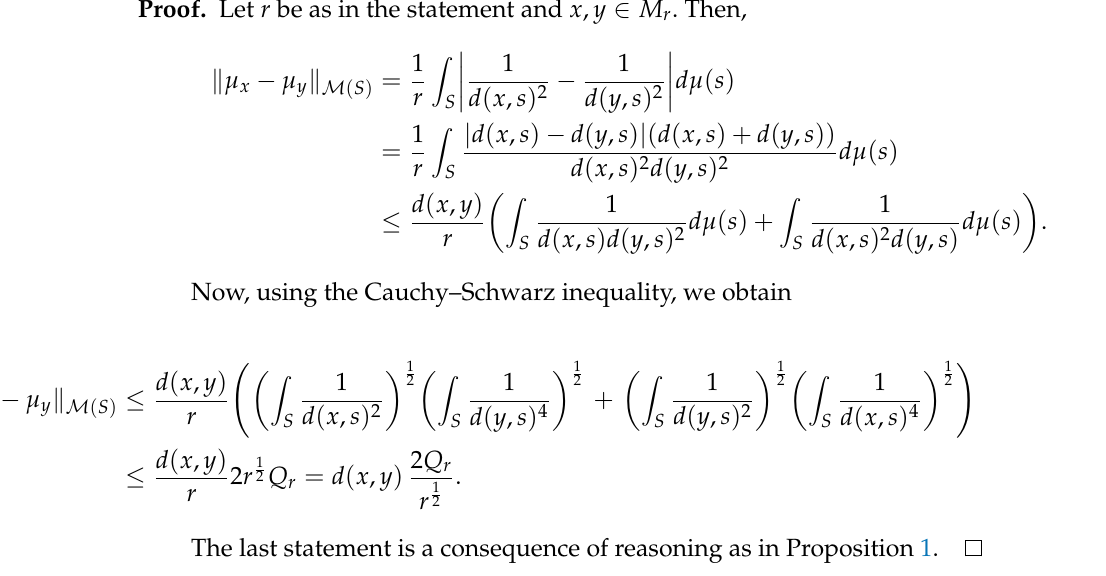
Figure 9. In red, the set C . In different shades of blue, the value of x ∈ M \ C . We have fixed some bands of constant value to facilitate the understanding of the graphic. Some sets M r are plotted in black for r ∈ { 1